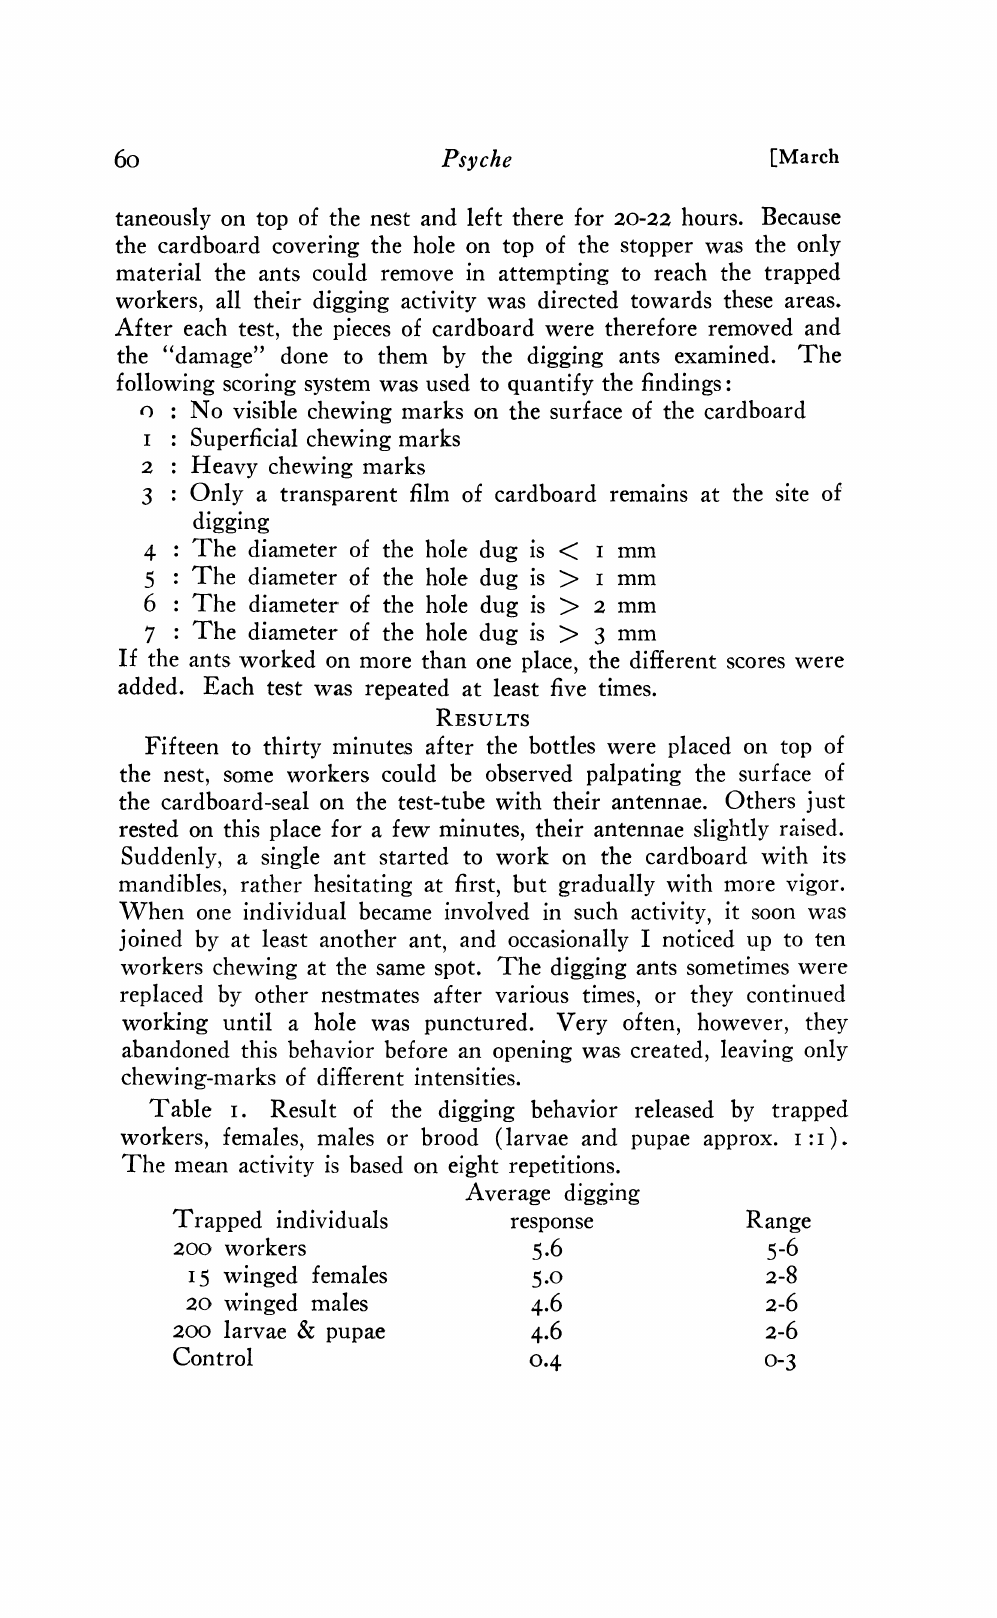
Table I. Result of the digging behavior released by trapped workers, females, males or brood (larvae and pupae approx. :I). The mean activity is based o.n eight